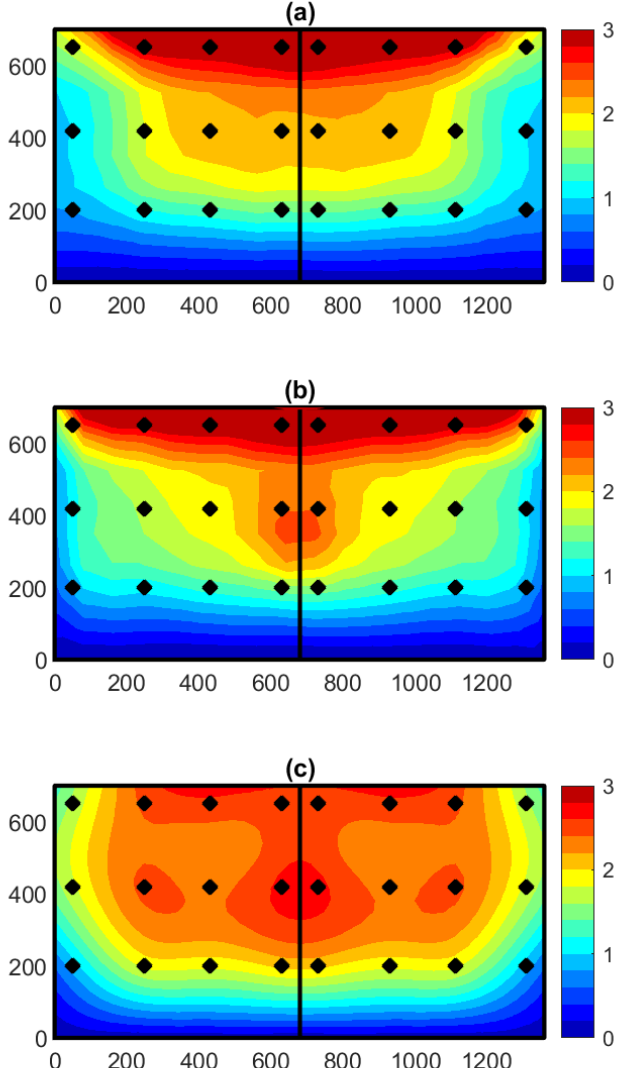
Figure 12. Absolute wear maps after calibration is performed for, ( a ) the PSD with smallest particles, radius, R = 50 mm, and ( b ) larger particles R = 100 mm, compared to the experimental results ( c ). x and y axes are the coordinates of the steel plates. The black dots represents the experimental coordinates where measuring of wear depth was performed. All units in